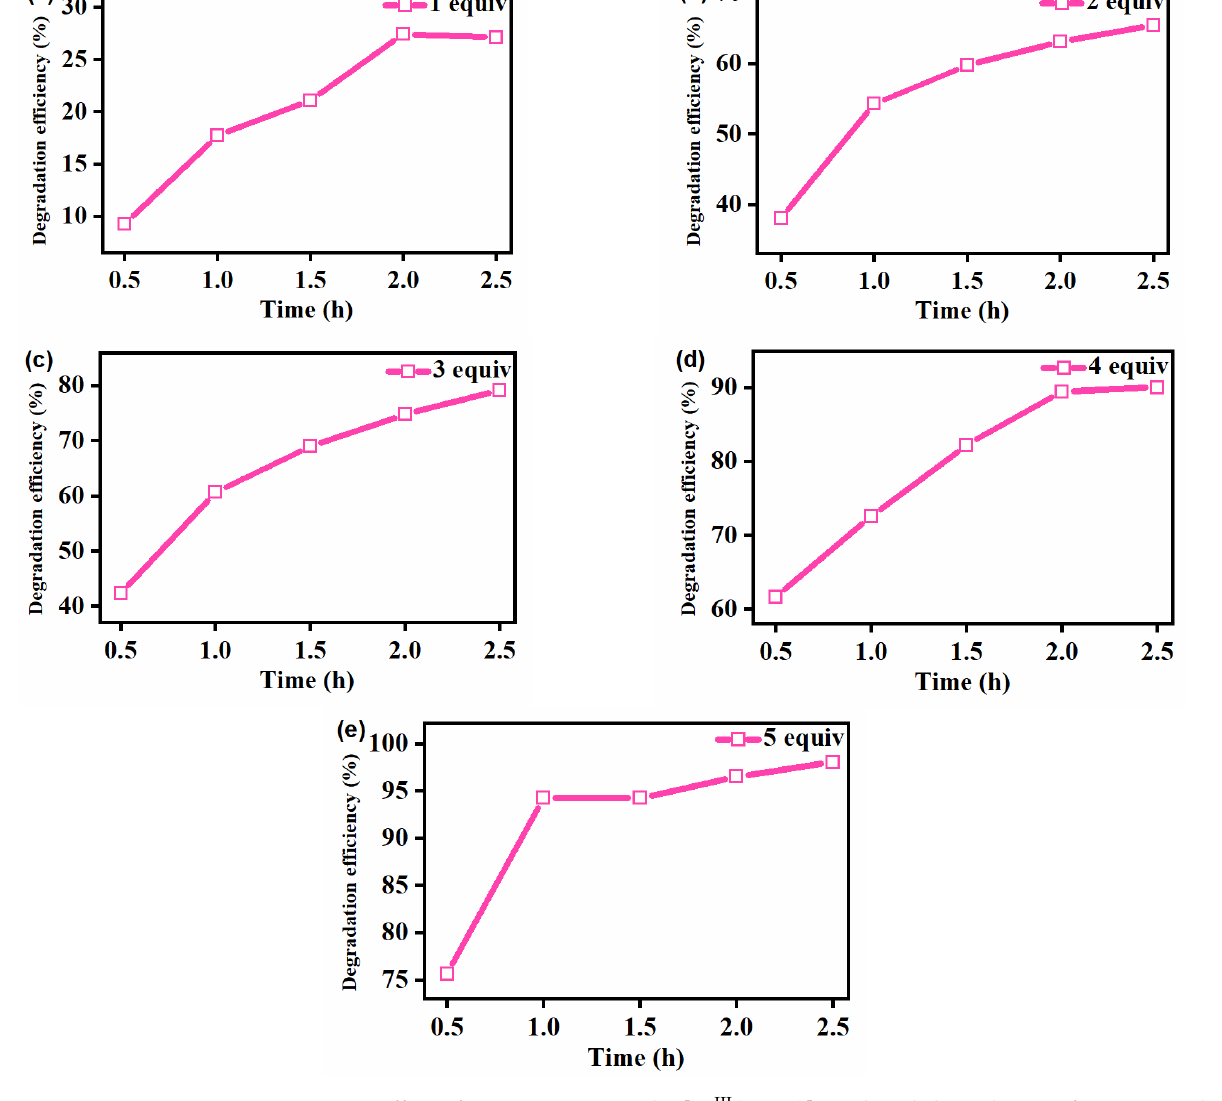
Figure 5. Effect of reaction time on the [Fe III (TCPP)]-catalyzed degradation of gentian violet by 1 equiv ( a ), 2 equiv ( b ), 3 equiv ( c ), 4 equiv ( d ) and 5 equiv ( e ) of PhIO. Conditions: gentian violet 0.05 mM; [Fe III (TCPP)] 0.005 mM; solvent MeOH and 303 K. Table 2. [Fe III (TCPP)]-catalyzed degradation 1 of gentian violet by various concentrations of PhIO under various reaction times.